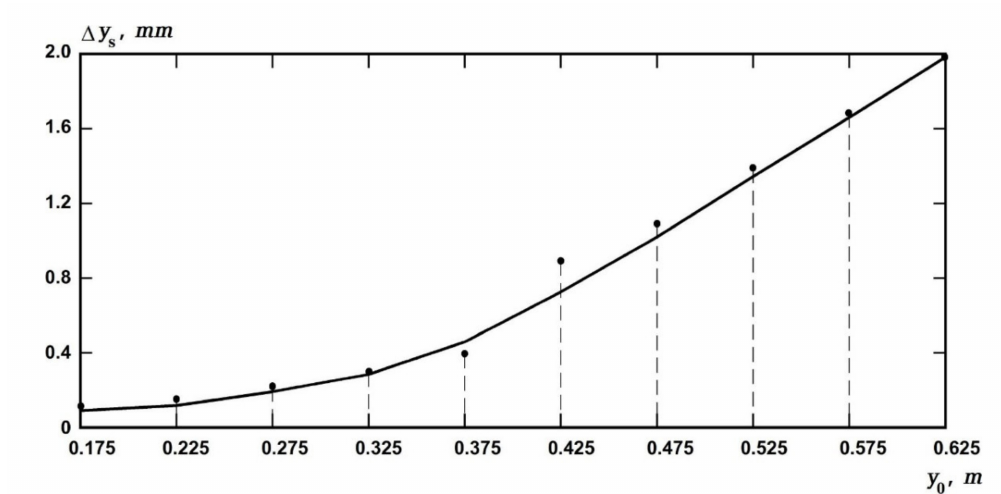
Figure 5. Dependence of the change in displacement, ∆ y s , on distance, y 0 , for each of the modeling options indicated in Table